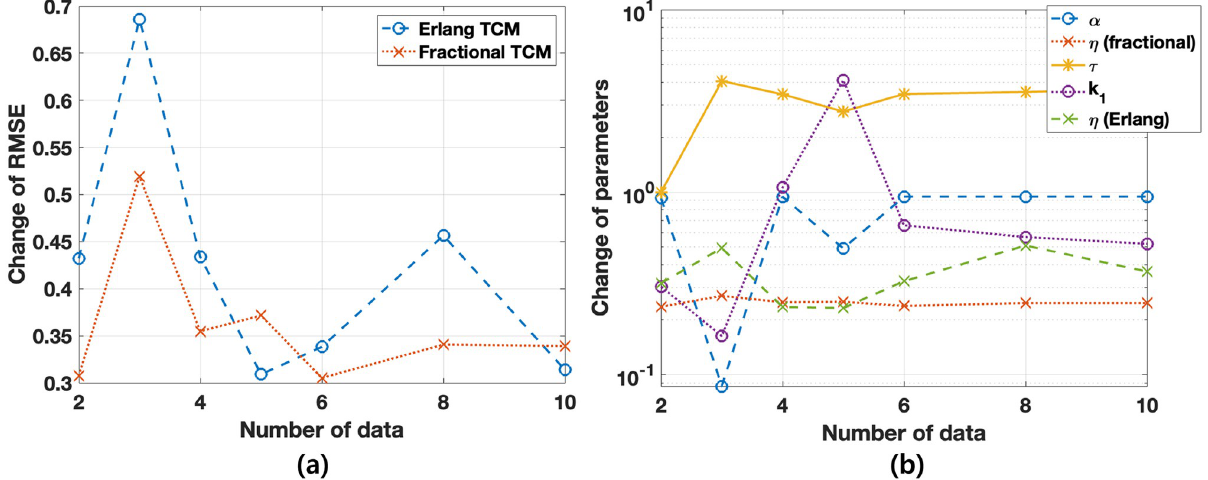
Fig 6. Changes in the parameter values and RMSE based on the amount of data. (a) RMSE is smaller as the amount of data increases. (b) Parameters converge as the amount of data increases.